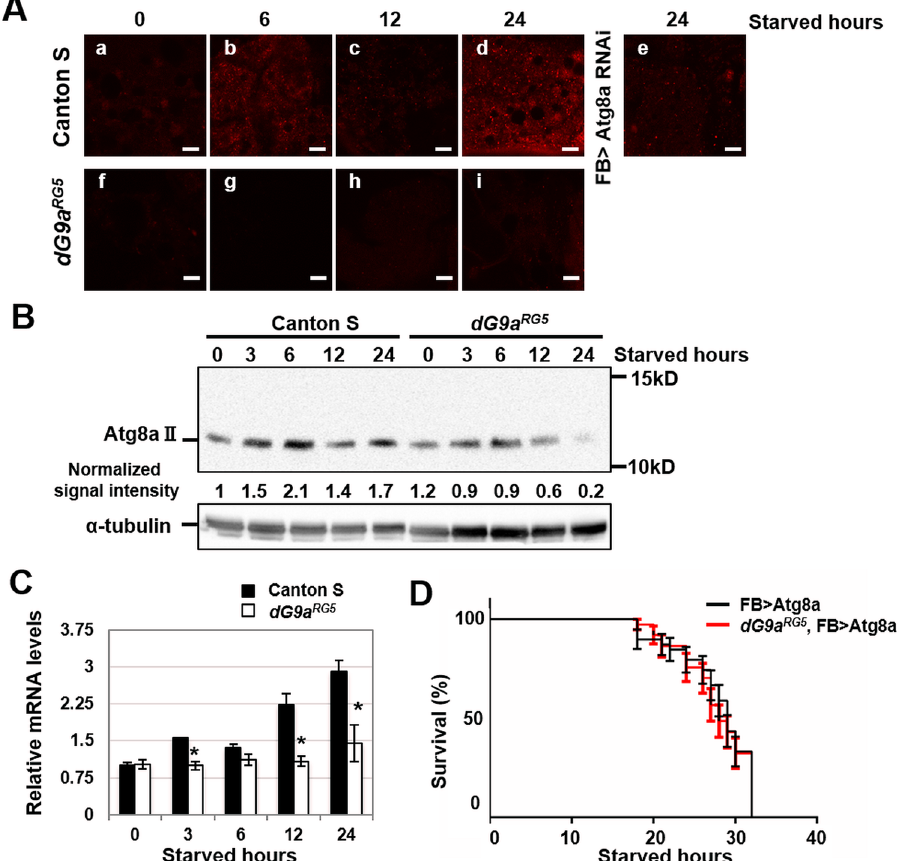
Figure 6. dG9a is responsible for the induction of autophagy under starvation stress. ( A ) Immunostaining of wild-type and dG9a RG5 mutant fat bodies under starvation conditions with an anti-Atg8a antibody. Strains: (a–d) Canton S (e) w; FB-GAL4/ + ; Atg8a HMS01328 / + (f–i) dG9a RG5 . Starved hours: (a,f) 0 h (b,g) 6 h (c,h) 12 h (d,i) 24 h. Scale bars, 10 μ m. ( B ) A western blot analysis of extracts from the starved wild-type and dG9a RG5 mutant. Blots were probed with anti-Atg8a and anti- α -tubulin antibodies. Signal intensity normalized with that of α -tubulin is shown. The full-length image of the blot is shown in Fig. S6B. ( C ) Quantification of mRNA levels by a RT-qPCR analysis of Atg8a in the starved wild-type and dG9a RG5 mutant. Results were normalized to α -tubulin and displayed as relative values to that of the 0-h starved wild-type n = 3. * P < 0.05. ( D ) The results of a viability assay under starvation conditions using the males of dG9a RG5 , FB > Atg8a (dG9a RG5 ; FB-GAL4/ Atg8a Scer/UAS.P/T.T:Avic/GFP-EGFP,T:Disc/RFP-mCherry ; + ) (n = 39 from 2 independent experiments) and FB > Atg8a ( + ; FB-GAL4/Atg8a Scer/UAS.P/T.T:Avic/GFP-EGFP,T:Disc/RFP-mCherry ; + ) (n = 38 from 2 independent experiments) strains P = 0.79. ( C,D ) Error bars represent